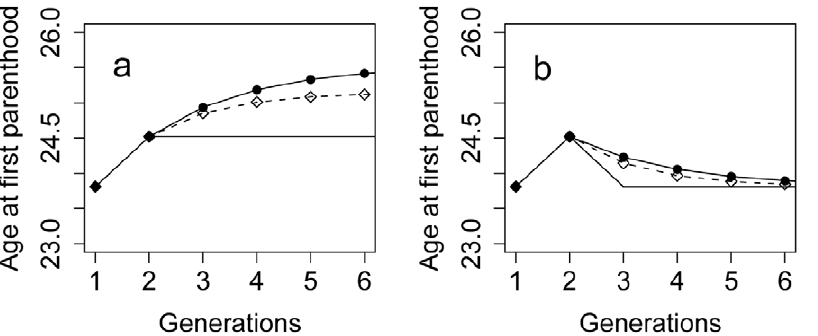
Figure 3. Predicted responses to a hypothetical intervention in the most deprived neighbourhood we studied whose effect is to raise family support by one standard deviation (equivalent to an increase in score of 5.91). We assume that changes in ideal age for parenthood lead to older ages at actual parenthood, and that these feed iteratively into the formation of the intended reproductive schedule of the next generation by cultural transmission. Parameter values used are drawn from Model 7 in table 2. (a) The intervention is implemented during the childhood of generation 1, and remains in place permanently. The plain line indicates the direct effect of the intervention alone. The line with solid circles represents its total effect, assuming that both the vertical and oblique intergenerational influences are cultural ones. The line with open diamonds represents its predicted total effect if the oblique effect is a cultural one, with the vertical intergenerational transmission being genetic and so not responding to the change in the mean parental age. (a) The intervention is implemented during the childhood of generation 1 for one generation only, and levels of family support return immediately to baseline. Again, the plain line is the direct effect of the intervention alone, the line with solid circles assumes that both the vertical and oblique effects are cultural ones, and the line with open diamonds assumes that only the oblique effect is a cultural one.